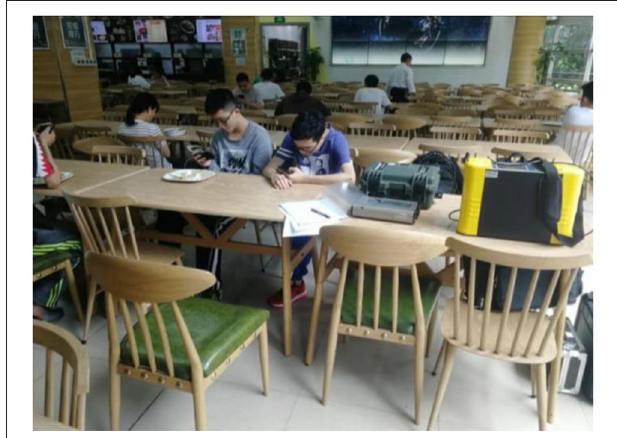
FIGURE 2 | Field layout of the indoor measuring instruments. Data from both sites were dynamically recorded by testers.